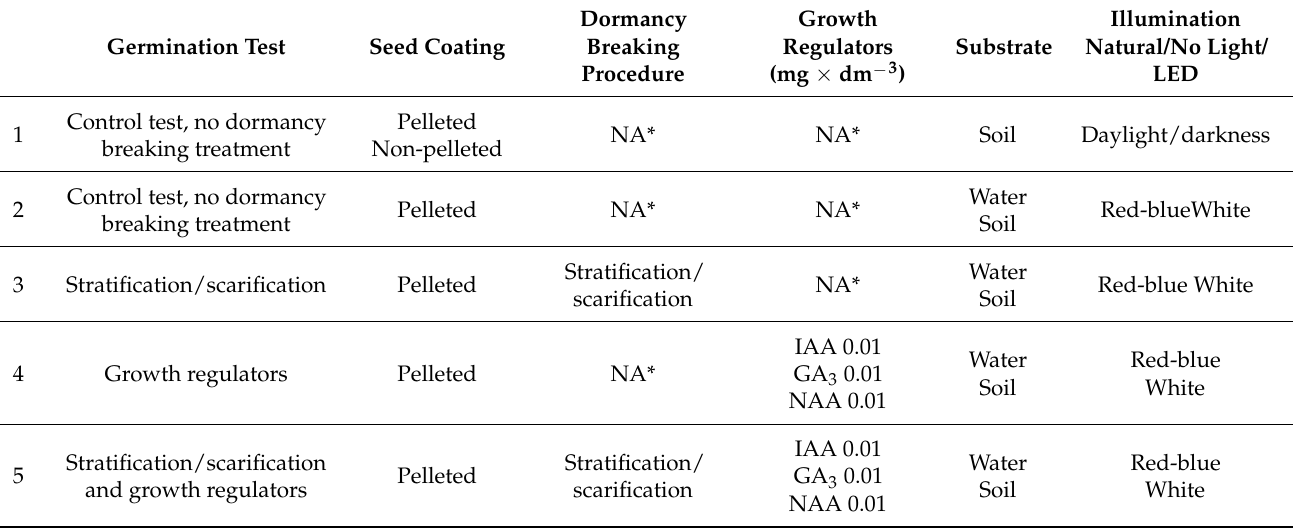
Table 1. Germination tests of pelleted P. sylvestris seeds in various substrate and light conditions. NA*—not applicable, IAA—indole-3-acetic acid, GA 3 —gibberellic acid, NAA—1-naphthaleneacetic